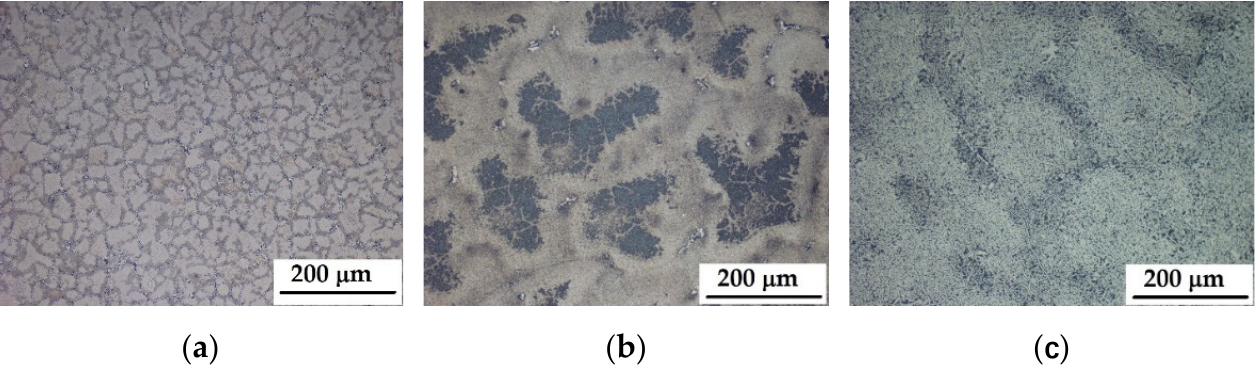
Figure 4. Structure of sample A: ( a ) Sample A—as-cast state; ( b ) Sample A50 after DS at rate 50 mm/h; ( c ) Sample A20 after DS at rate 20 mm/h.